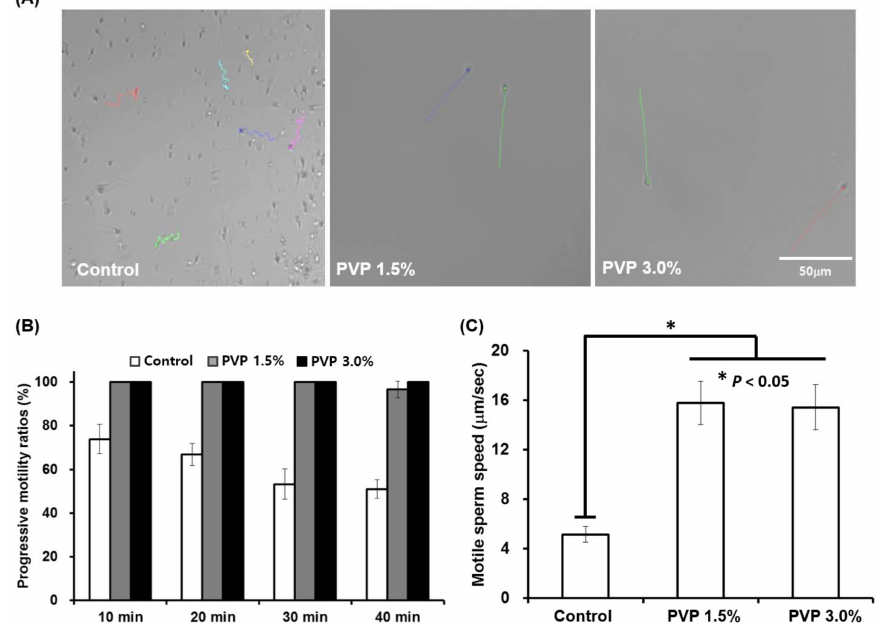
Figure 4. Motility analysis of sperm selected by the SSC for different PVP concentrations of 0, 1.5%, and 3%. ( A ) Real-time tracking of sperm at the outlet of the SSC, showing different progression patterns depending on the PVP concentrations (colored lines). ( B ) Progressive motility ratios in the control (0%), 1.5%, and 3% PVP media measured every 10 min at the outlet of the SSC. ( C ) Sperm velocities measured at the outlet of the SSC for the control, 1.5%, and 3% PVP media. All data are expressed as means ± SEM for triplicate measurements. The significant differences are indicated by asterisks (* p < 0.05 against control); scale bar: 50 µ